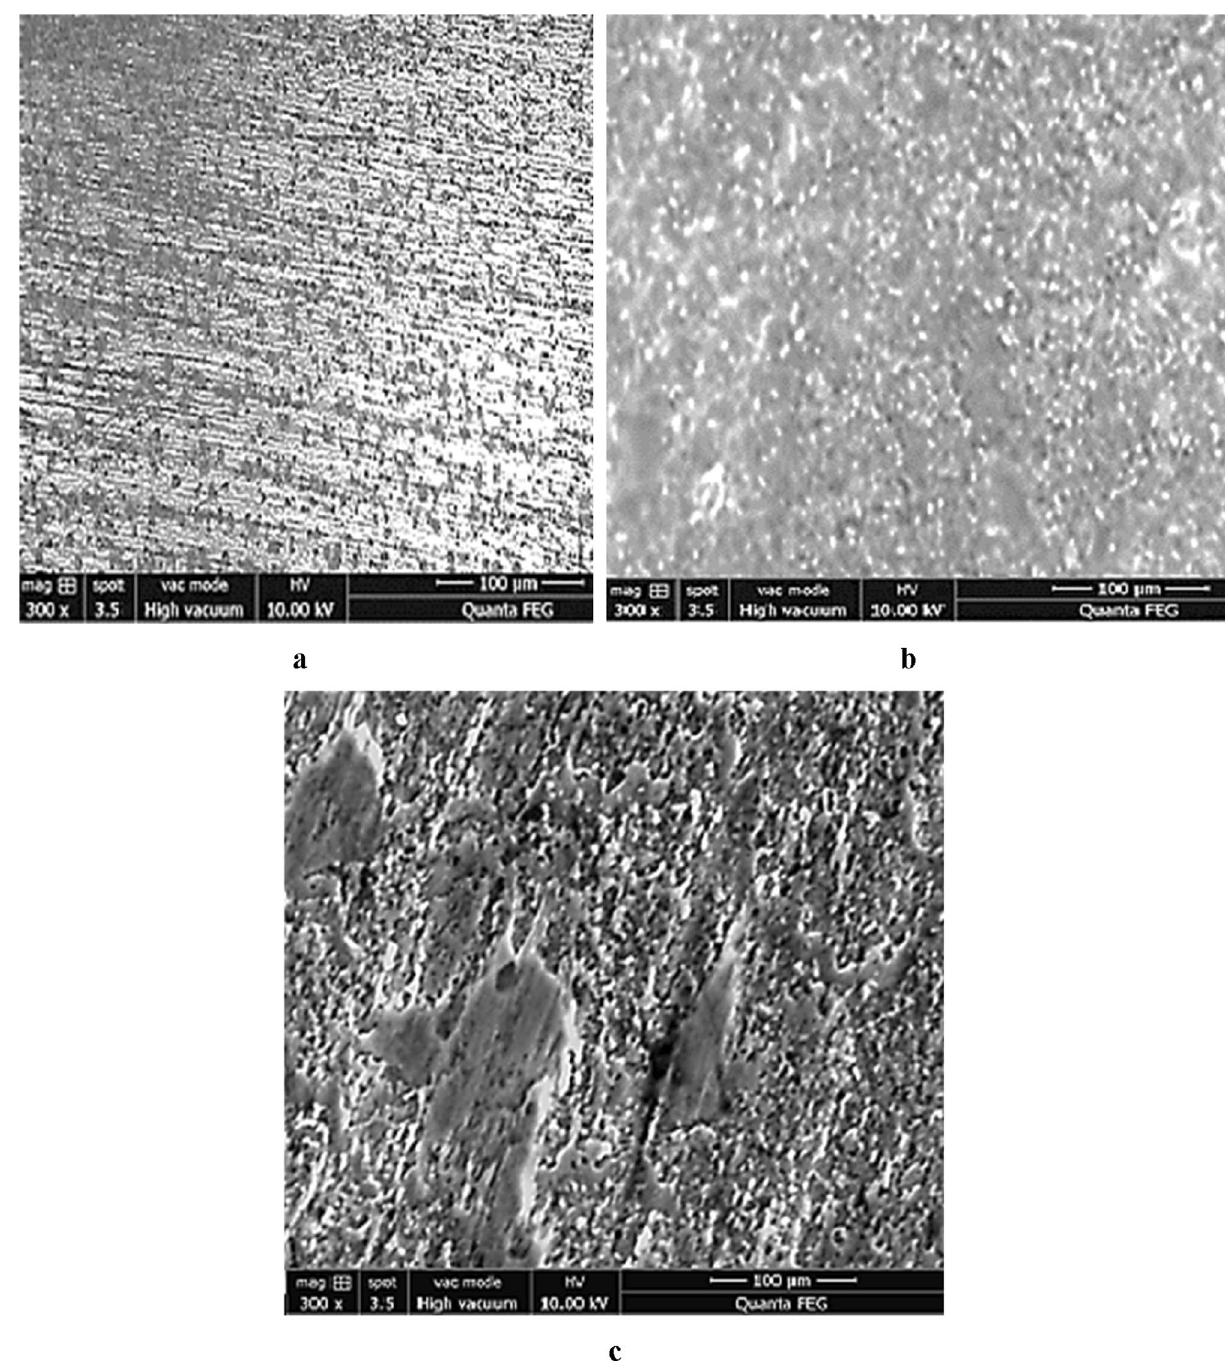
Figure 9. SEM micrographs of attacked zones; ( a ): base metal zone, ( b ): Heat affected zone and ( c ): melted